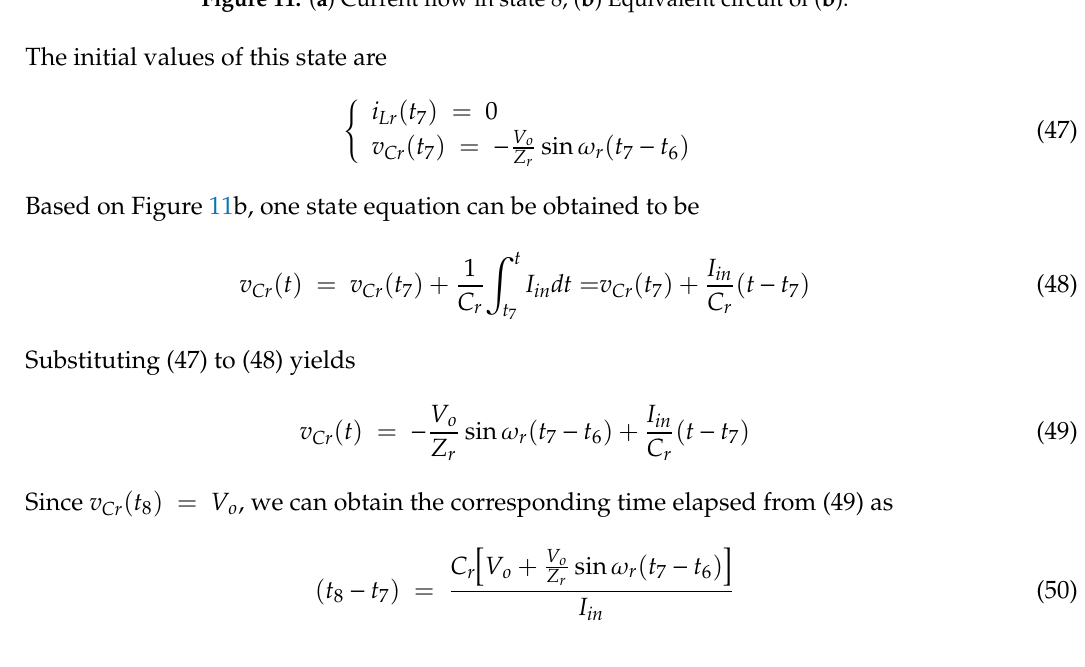
Figure 11. ( a ) Current flow in state 8; ( b ) Equivalent circuit of ( b ).